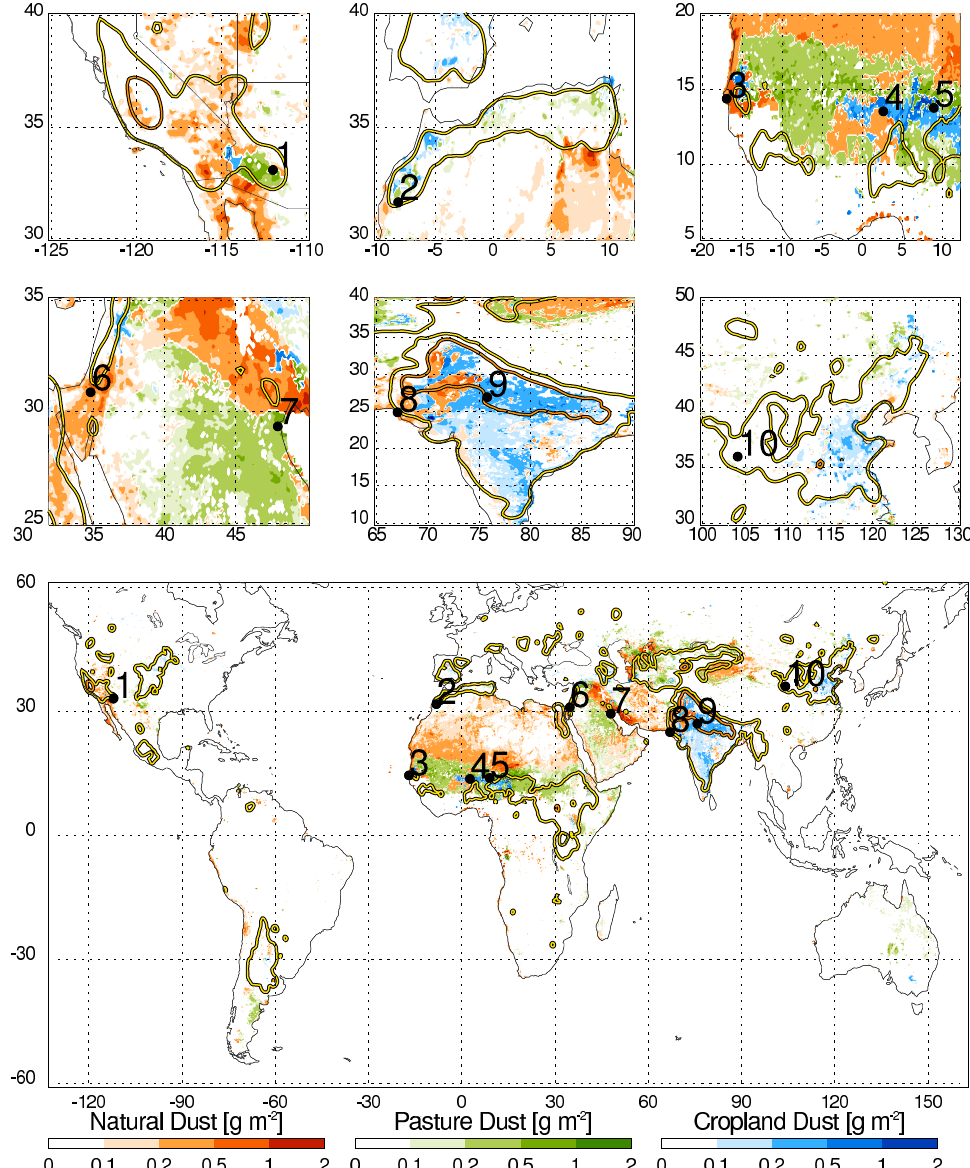
Fig. 2. Global (lower panel) annual mean distribution of M-DB2 dust column burden (gm − 2 ) over areas with less than 30% (Natural Dust; red shading) and more than 30% land-use -with an additional distinction between the prevalence of pasture over cropland (pasture dust; green shading) and cropland over pasture (cropland dust; blue shading), 0.5 (yellow contour) and 2.5 (orange contour) column burden (mgm − 2 ) of IASI NH 3 , with the numbers 1 to 10 indicating the position of the AERONET sites of Fig. 4, and the upper panels providing a zoom over 6